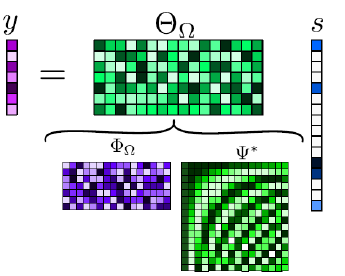
Figure 1: Illustration of the algebraic problem. Extracted from Schulz et al. [4] Compressive sensing rely on two basic ideas: sparsity as well as incoherence